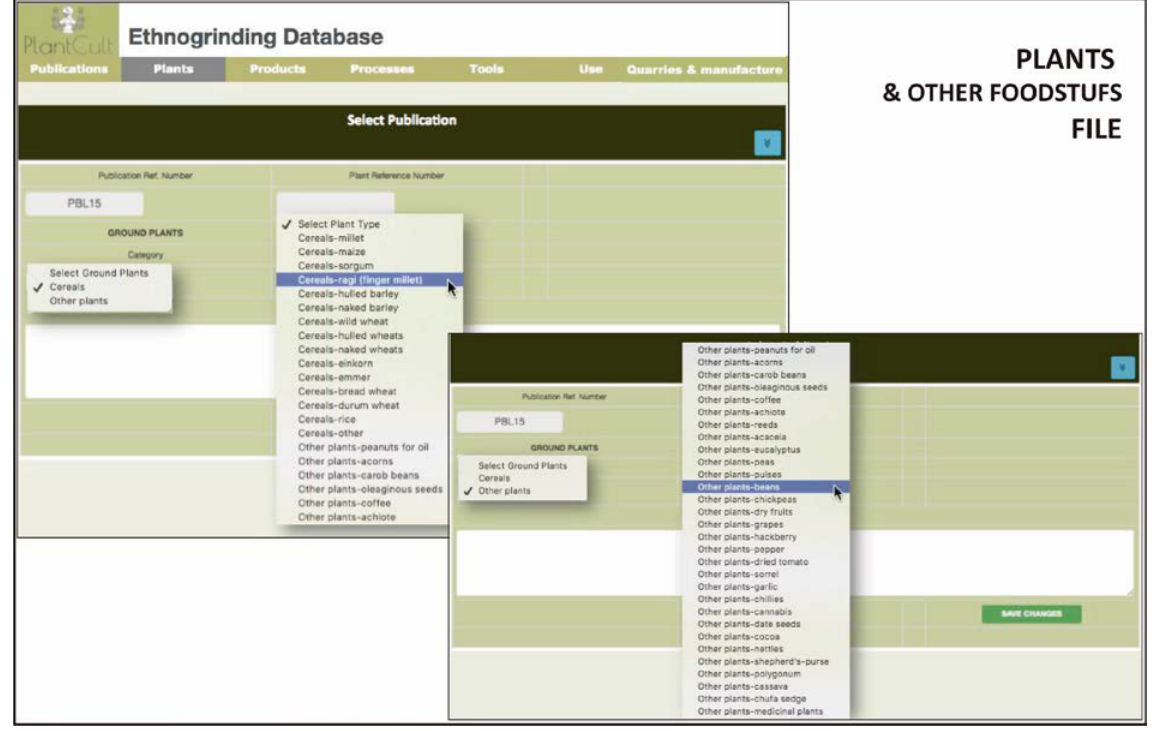
Figure 4. The Plants